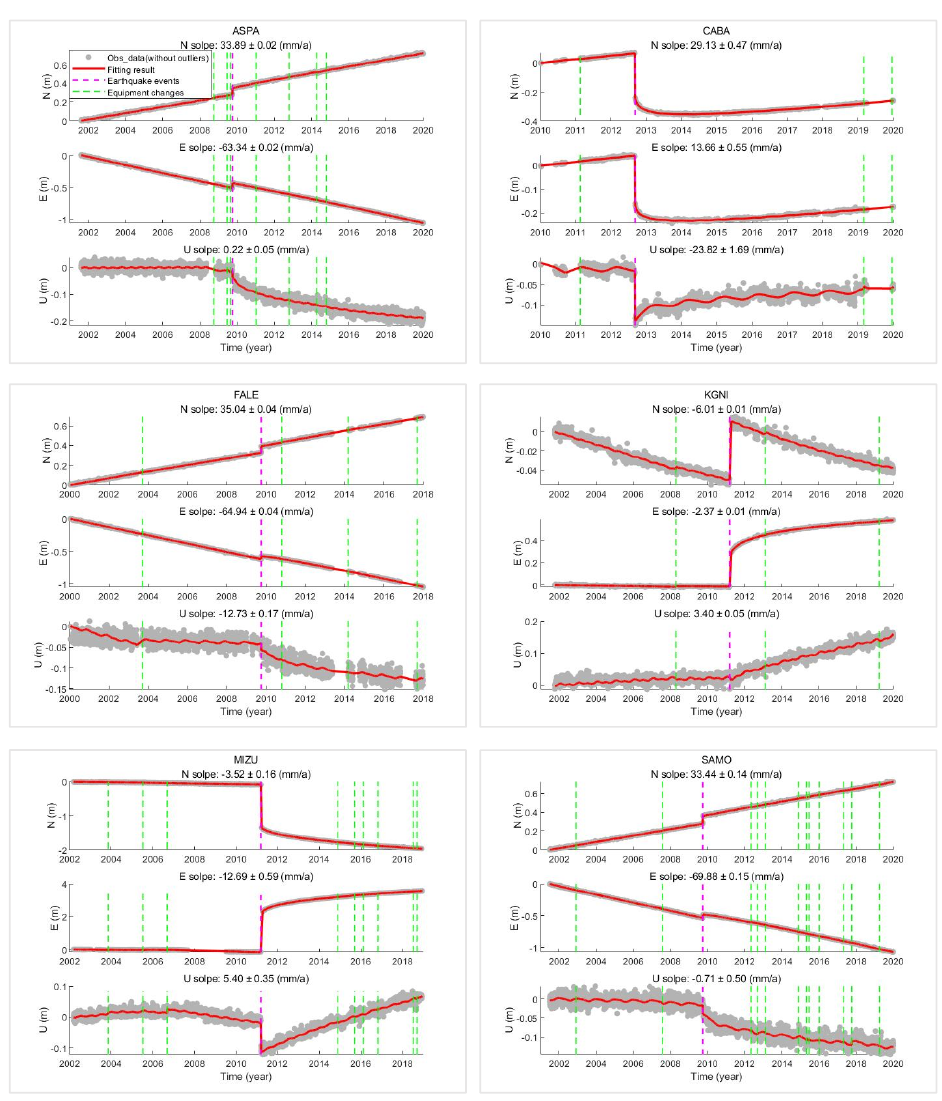
Figure 13. Fitting results of some sites with different trajectory characteristics.